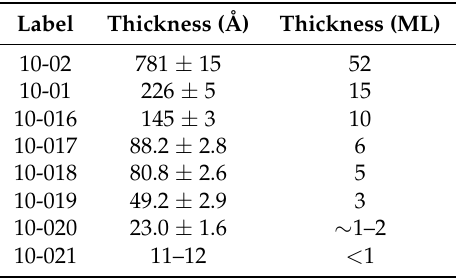
Table 1. Characterization of the obtained pentacene films. The thickness in ML (monolayers) assumes 1 ML (cid:39) 15